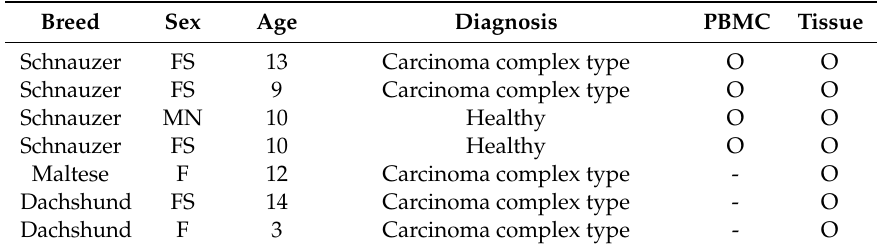
Figure 1. Scheme of research flow and specimens. DMR: differentially methylated region, PBMC: peripheral blood mononuclear cell, RRBS: reduced representation bisulfite sequencing. Table 1. Patient information.